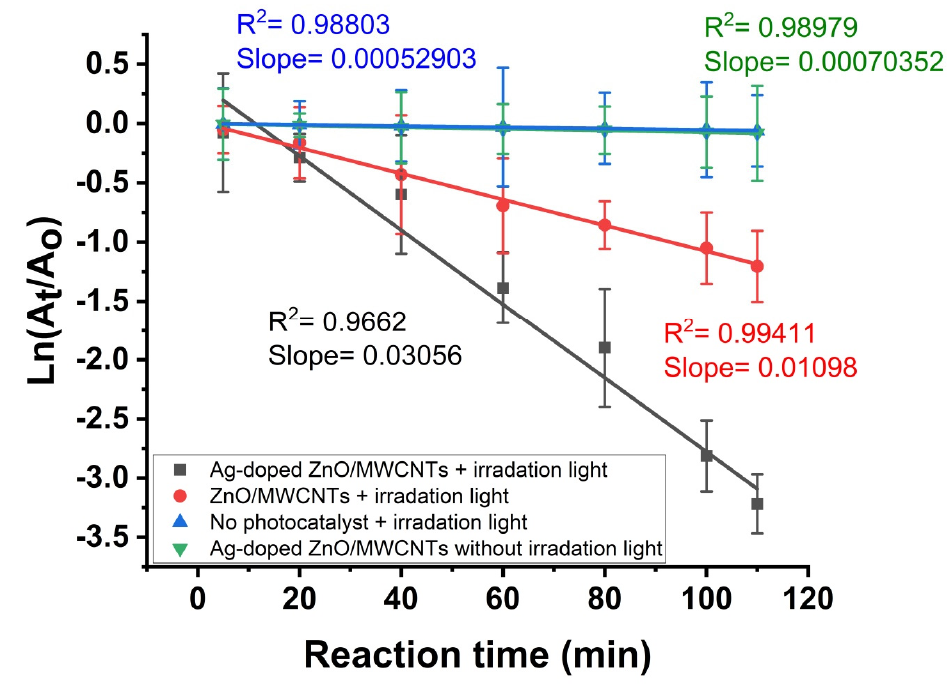
Figure 7. Absorption kinetic via pseudo-first order against RhB in the presence and absence of photocatalyst (ZnO/MWCNTs and Ag-doped ZnO/MWCNTs) and irradiation light. Table 1. The catalytic degradation of different organic pollutants over other nanocomposite-based Ag/ZO/MWCNTs catalysts.